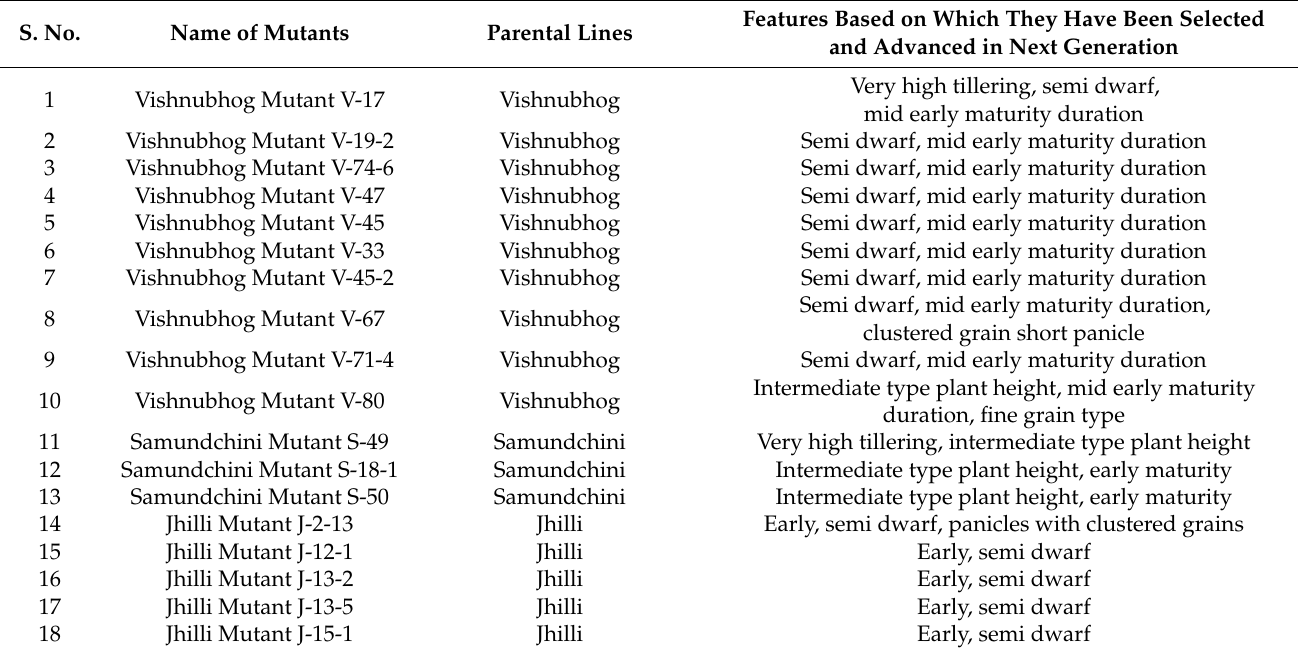
Table 1. Details of true to type mutants and their special features as obtained in the M3 generation. S.